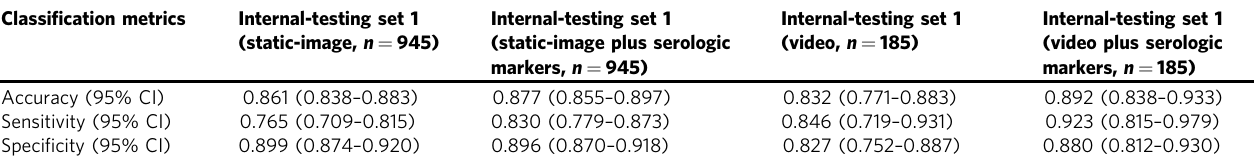
Table 3 Classi fi cation metrics of HTNet with ultrasound images and serologic markers as